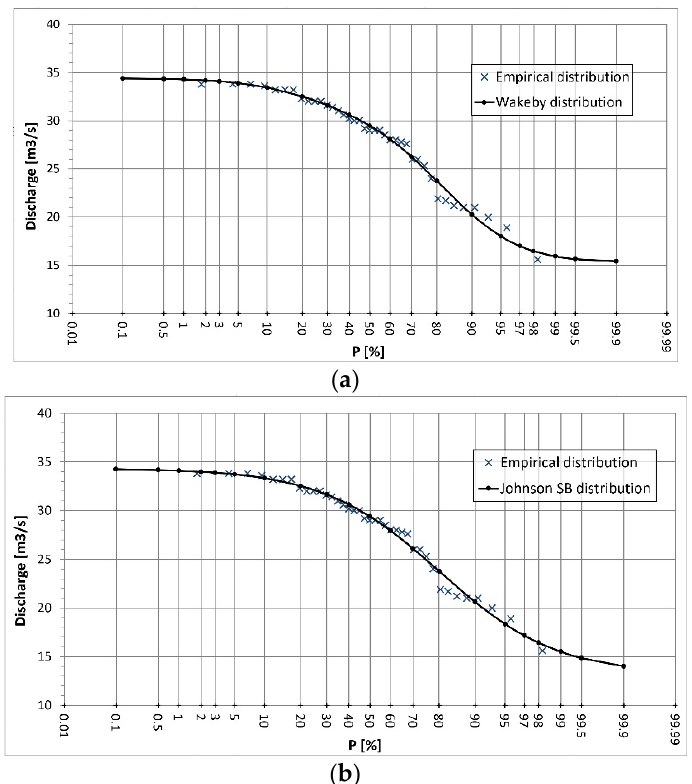
Figure 6. Minimum discharges at Lungoci gaging station (Siret River): ( a ) Wakeby distribution and ( b ) Johnson SB distribution.